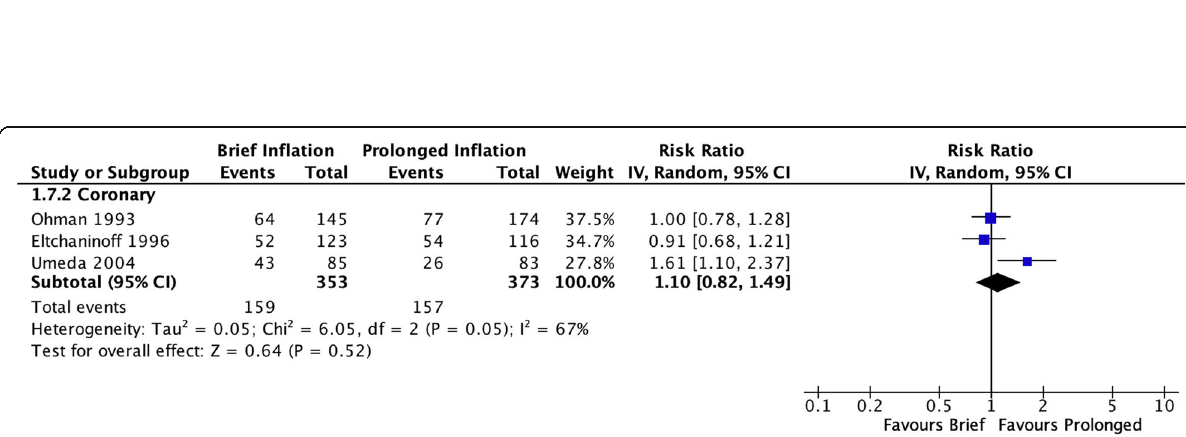
Fig. 8 Risk of stenosis on follow-up angiogram performed at least 3 months following index